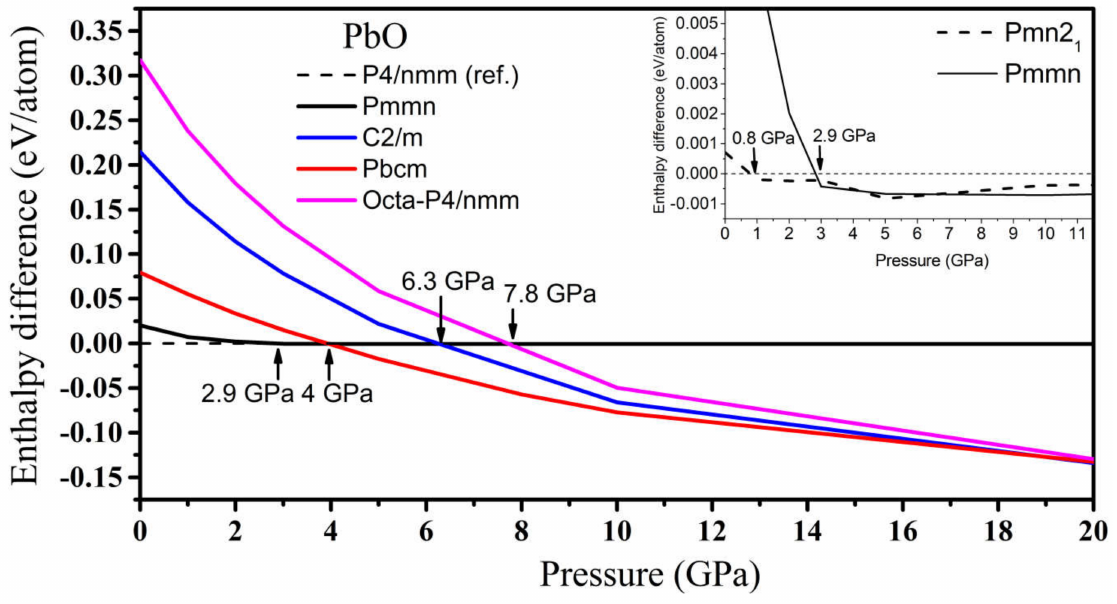
Figure 8. The enthalpy difference ( ∆ H = H GA − H tetra ) of high-pressure phases of PbO, where H GA is the total enthalpy of the GA phase and H tetra is the total enthalpy of the reference tetragonal PbO. Inset: the enthalpy difference for the Pmn2 1 phase of PbO at low pressure.